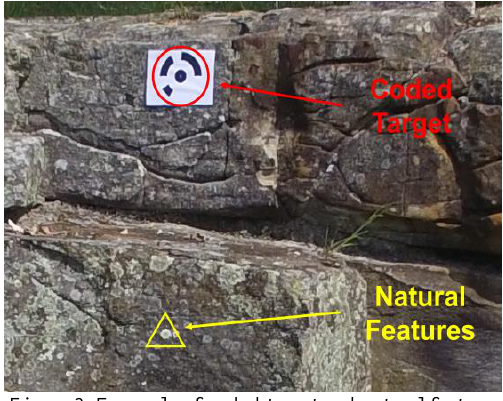
Figure 3. Example of coded target and natural feature.